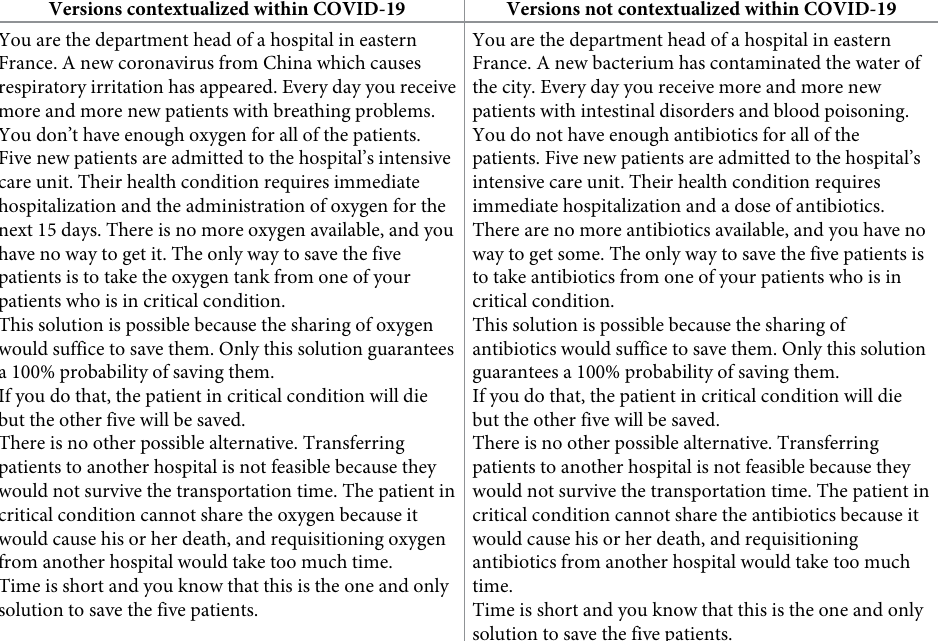
Table 4. The versions of the TRIAGE dilemma added in experiment 2 (translated from French) in order to exam- ine the plausibility of an action. Versions contextualized within COVID-19 Versions not contextualized within